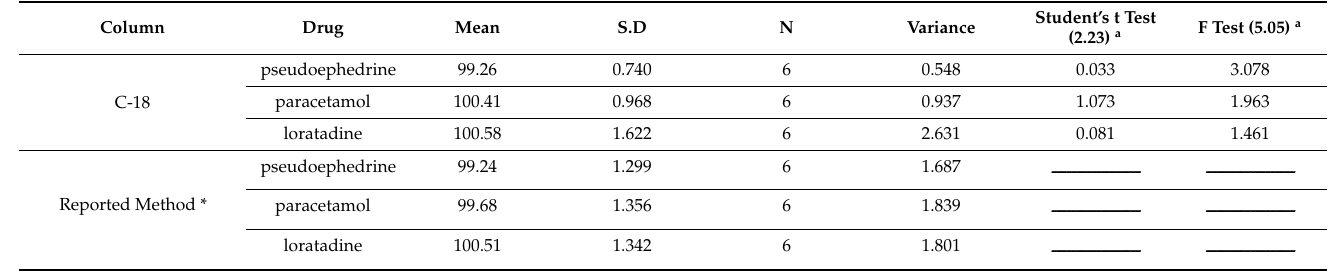
Table 7. Statistical comparison of the results obtained using the proposed method and the reported method for the analysis of the analytes in bulk